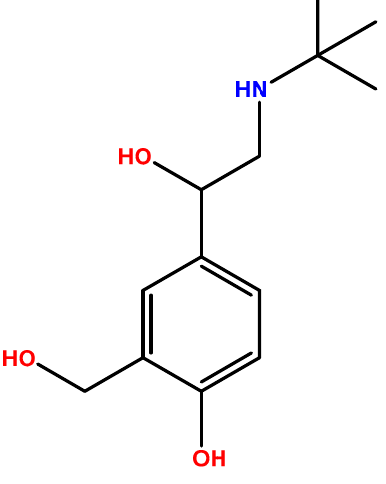
Figure 1. Chemical structure of